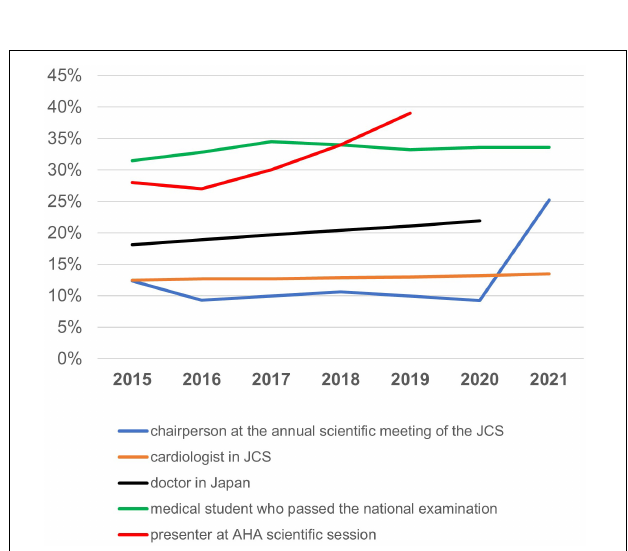
FIGURE 6 | Changes in rates of female cardiologists. The changes in female cardiologist rates of female chairpersons at the annual scientific meeting of the JCS, female cardiologists in JCS, female doctors in Japan, female medical students who passed the national examination for medical practitioners, and female presenters at the AHA scientific session. JCS, Japan Circulation Society; AHA, American Heart